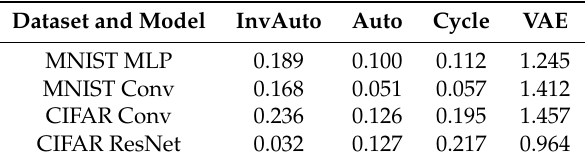
Figure A3. Comparison of the ratio of MSE of the off-diagonal and diagonal of DE for InvAuto, Auto, Cycle, and VAE on MLP, convolutional (Conv), and ResNet architectures and MNIST and CIFAR datasets. Table A1. Test reconstruction loss (MSE) for InvAuto, Auto, Cycle, and VAE on MLP, convolutional (Conv), and ResNet architectures and MNIST and CIFAR datasets. VAE has significantly higher reconstruction loss by